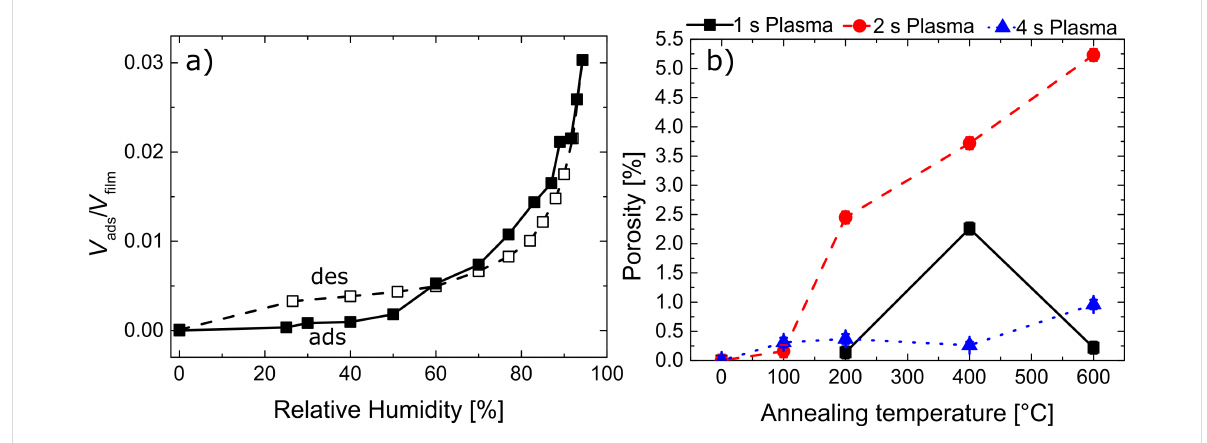
Figure 7: a) Example of an adsorption/desorption isotherm reported as volume of the adsorptive ( V ads / V film ) as a function of the relative humidity for the zincone-like layers; the example is reported for the layer deposited with 1 s plasma exposure time and annealed at 400 °C. b) Porosity values for the zincone-like layers as a function of the annealing